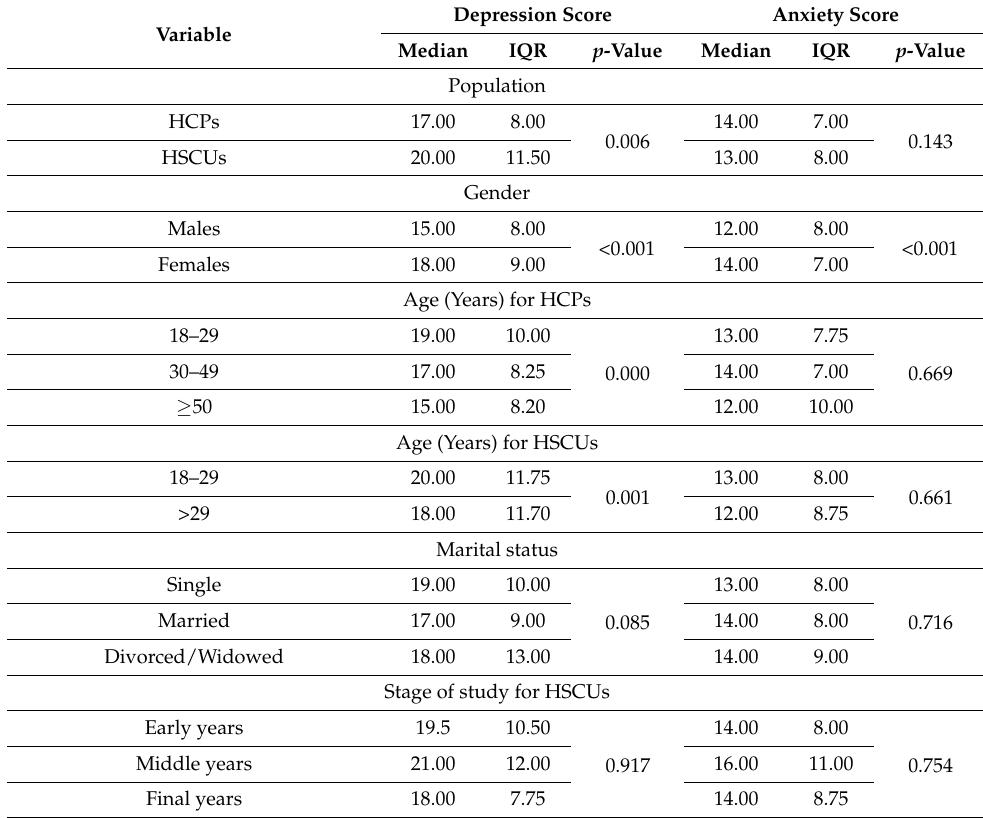
Table 3. Median (interquartile range, IQR) scores of depression and anxiety stratified by partici- pants’